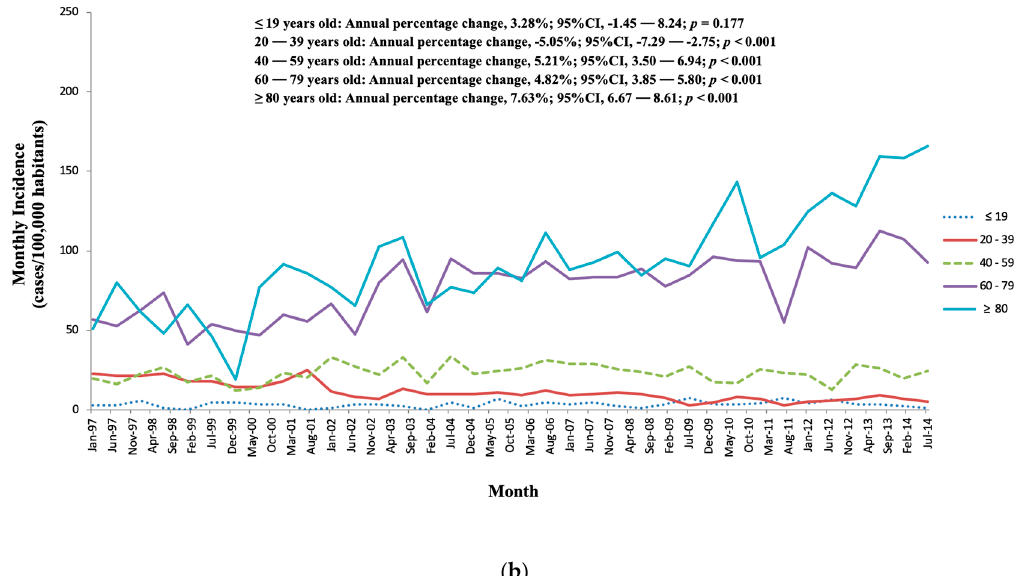
Figure 3. Incidence of infective endocarditis according to gender ( a ) and age groups ( b ) from 1997 to 2014 in Spain.